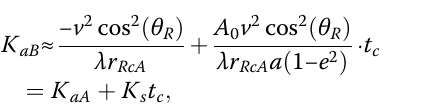
where K aA is the Doppler FM rate of the reference target A nent of the Doppler FM rate.